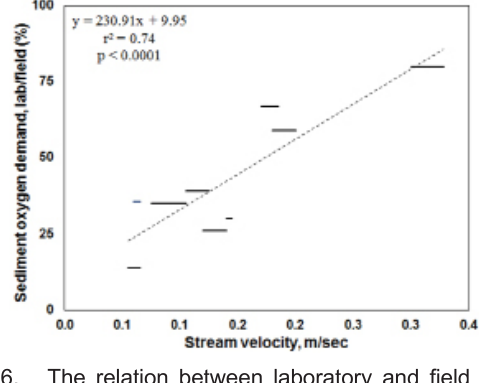
Fig. 4. Sediment oxygen demand (mg O m -2 h -1 ) at fixed Fig. 6. The relation between laboratory and field mea- 2 oxygen concentration and temperature versus surements of the sediment oxygen demand mean organic content in the upper 3 cm of the versus the water velocity in the stream during the sediment. field